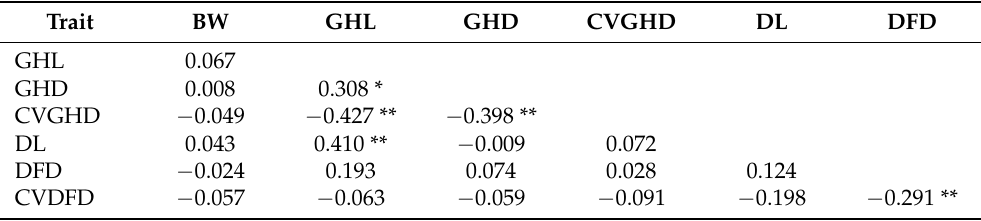
Table 4. Spearman’s Rho phenotypic correlations between fiber traits.